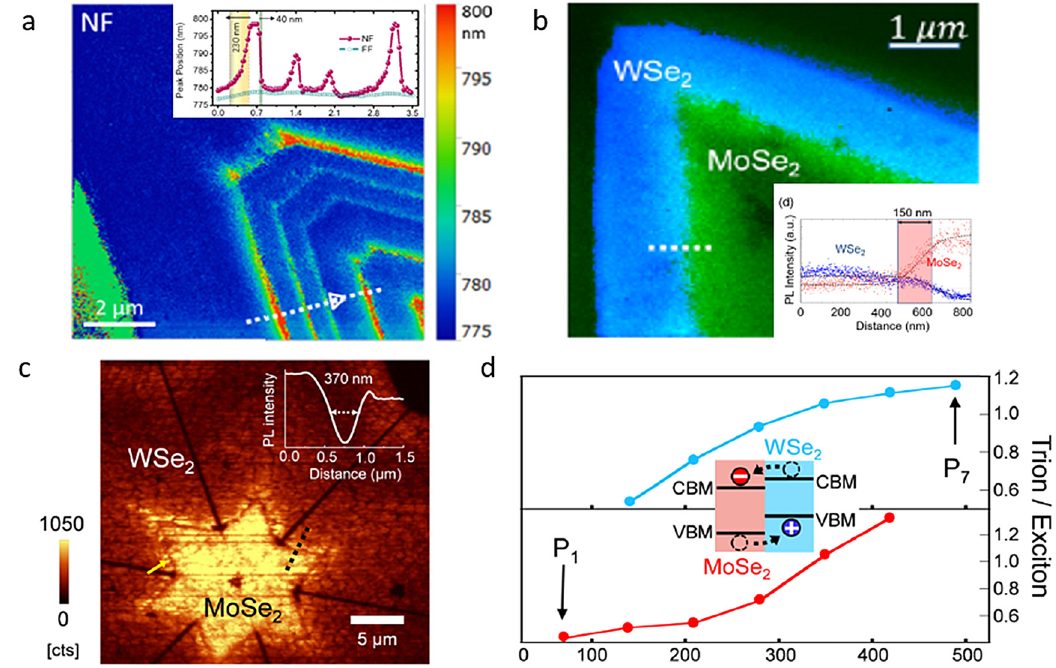
Figure 5: Near-field images of lateral HJ of WSe 2 /MoSe 2 . (a) TEPL image. Inset: the line profile obtained along the white dash lines in the TEPL image. Reproduced with permission from ref. [97]. Copyright 2019, Optical Society of America. (b) TEPL image. Inset: the line pro fi le highlighted white dashed line in TEPL image. Reproduced withpermissionfromref.[96].Copyright2018,AmericanPhysicalSociety.(c)Near- fi eldPLimage.Inset:thelinepro fi lehighlightedblackdash in near- fi eld PL image. (d) Plot of the trion/exciton ratio of WSe 2 (upper) and MoSe 2 (lower). Inset: the band alignment of MoSe 2 /WSe 2 lateral HJ. Reproduced with permission from ref. [98]. Copyright 2019, Optical Society of America.